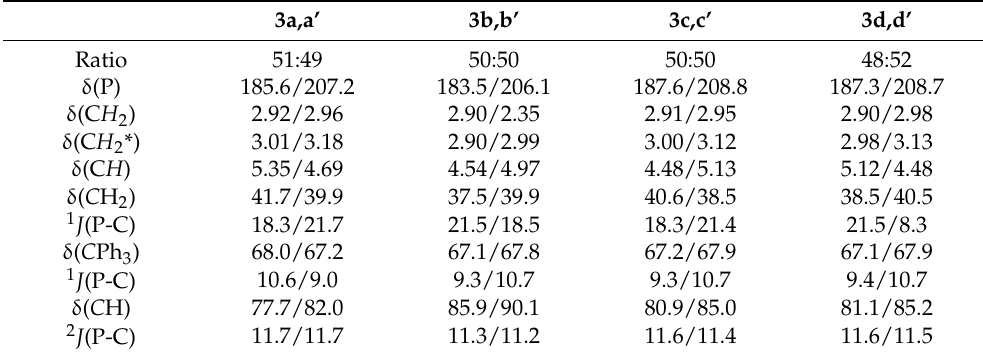
Table 1. Selected NMR spectroscopic data of 3a,a’ – d,d’ measured in CDCl 3 , chemical shifts in ppm, and coupling constants in Hz. See Supplementary Materials for more data and spectra.